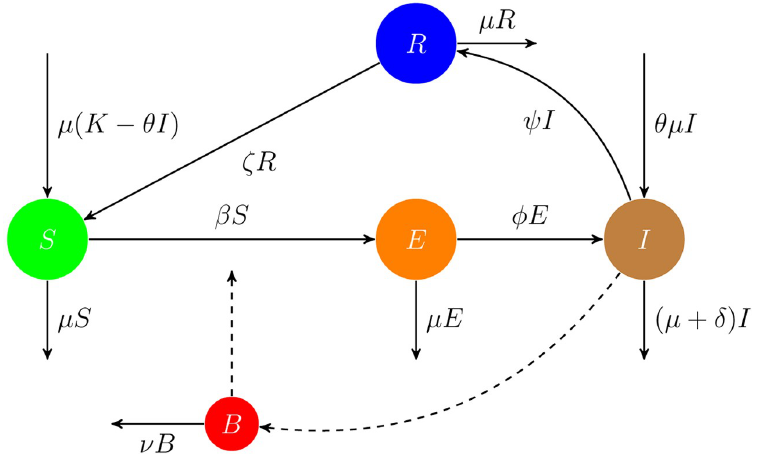
Fig 1. The flow chart of the listeriosis disease model. The dashed lines indicate influences but not flow of individuals.